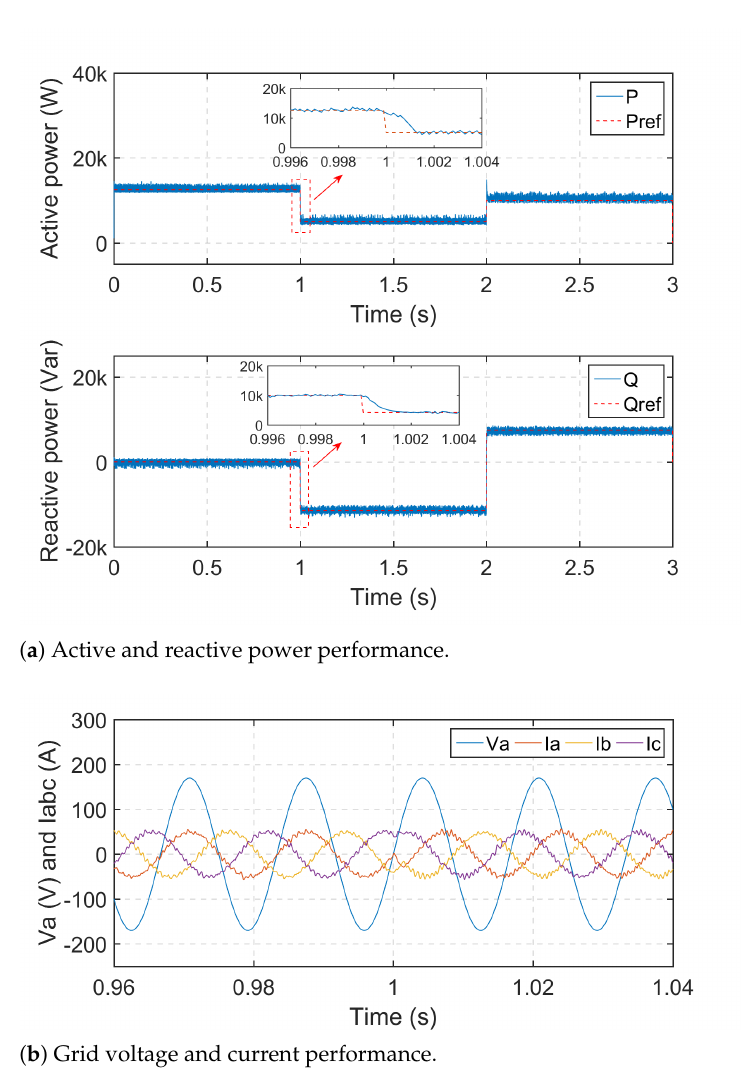
Figure 7. Performance by using the model predictive control (MPC) for the system in Ref.